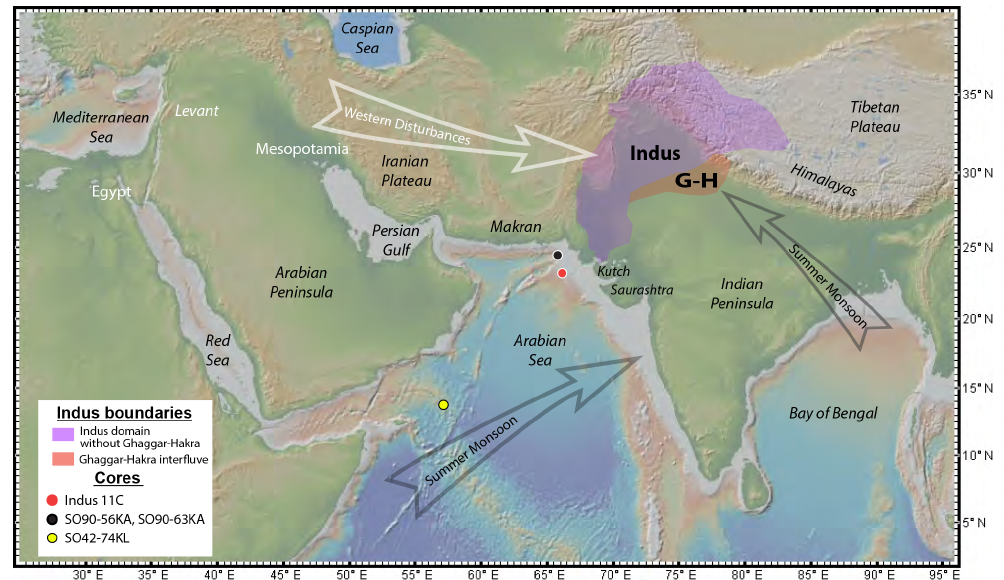
Figure 1. Physiography, winds and precipitation sources for the Harappan domain. The dominant source during summer monsoon is the Bay of Bengal while western disturbances provide the moisture during winter. The extent of the Indus basin and Ghaggar-Hakra (G-H) interfluve are shown with purple and brown masks, respectively. Locations for the cores discussed in the text are shown.